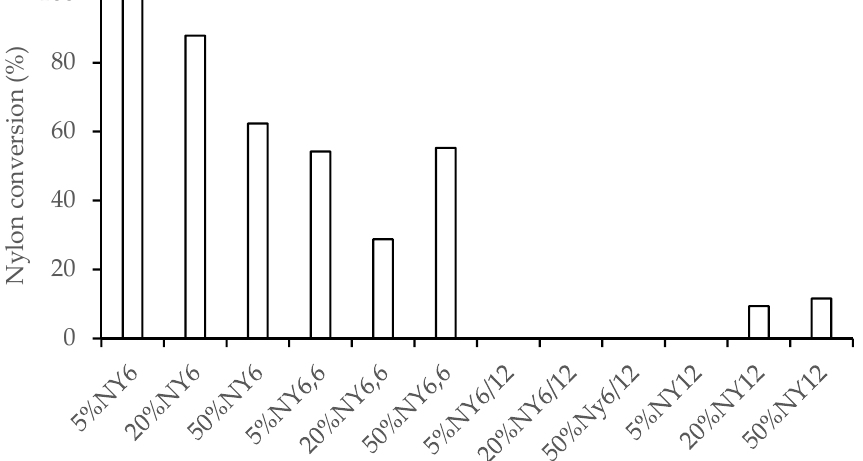
Figure 4. Estimated nylon conversion in the co-liquefaction of F. serratus as calculated by FTIR (see Supplementary Materials for the full method) .